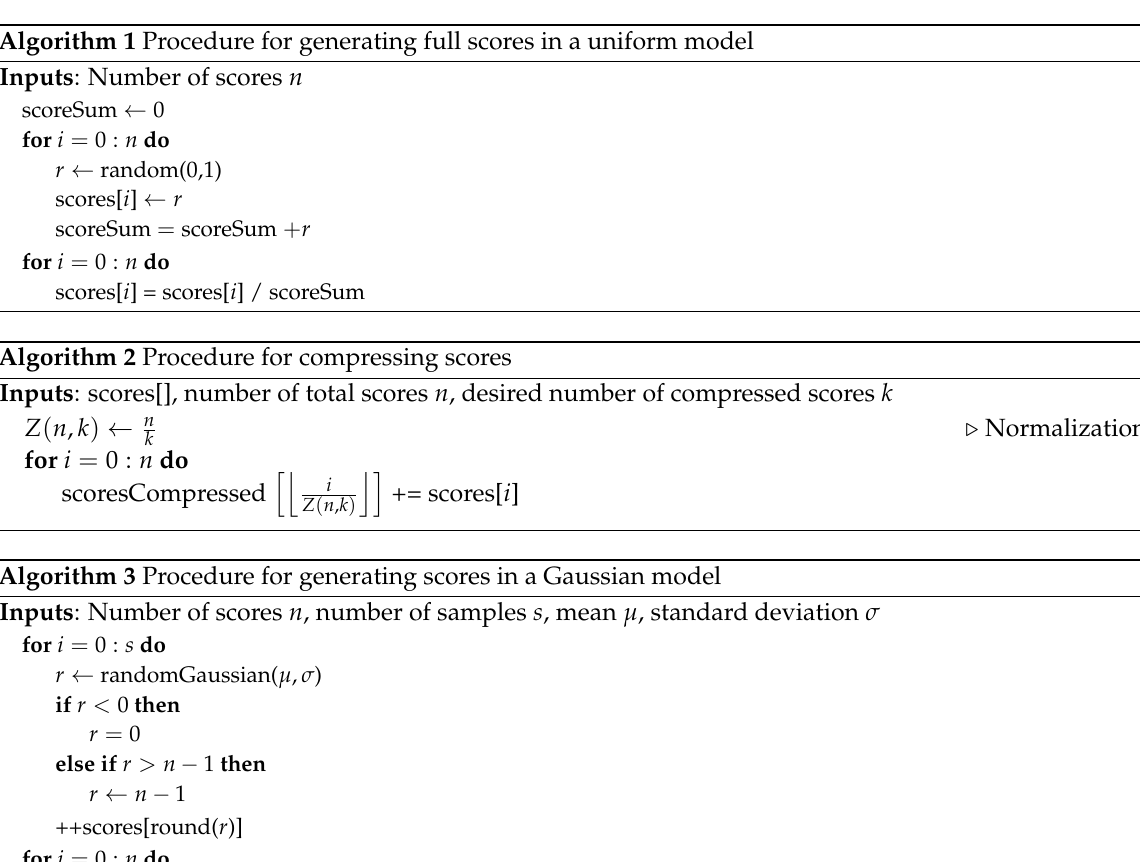
Algorithm 1 Procedure for generating full scores in a uniform model